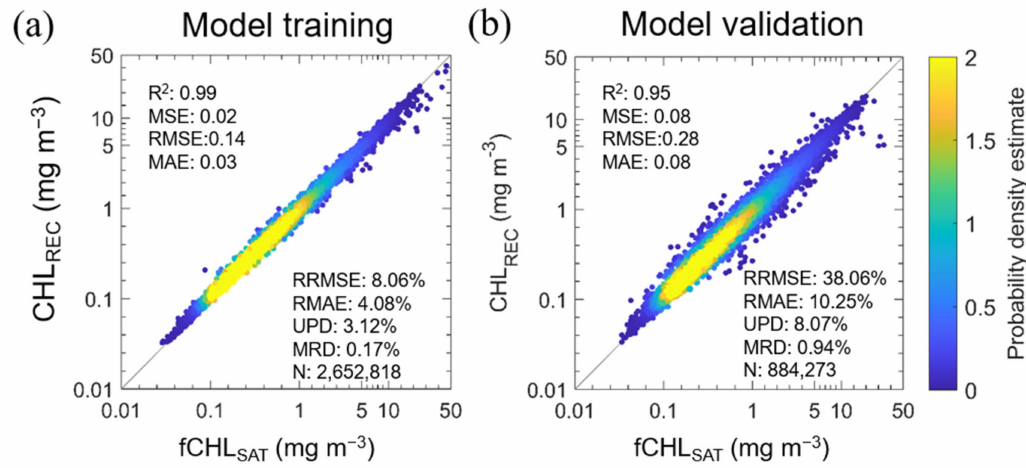
Figure 5. Probability density estimate (PDE) for scatter plots of the comparison between filtered satellite CHL measurements (fCHL SAT ) and the reconstructed CHL estimates (CHL REC ), which were derived from the machine-learning-based RF model for the data reconstruction, in the ( a ) training and ( b ) validation processes. For e ffi ciency of graphical representations, figures are illustrated using 3% of each training set ( N = 79,584) and validation set ( N = 26,528) that were randomly extracted for only this figure (not in analysis). Still, all the statistical results were from the total training and validation sets. For the computation of the PDE at each point, the kernel smoothing function was used.